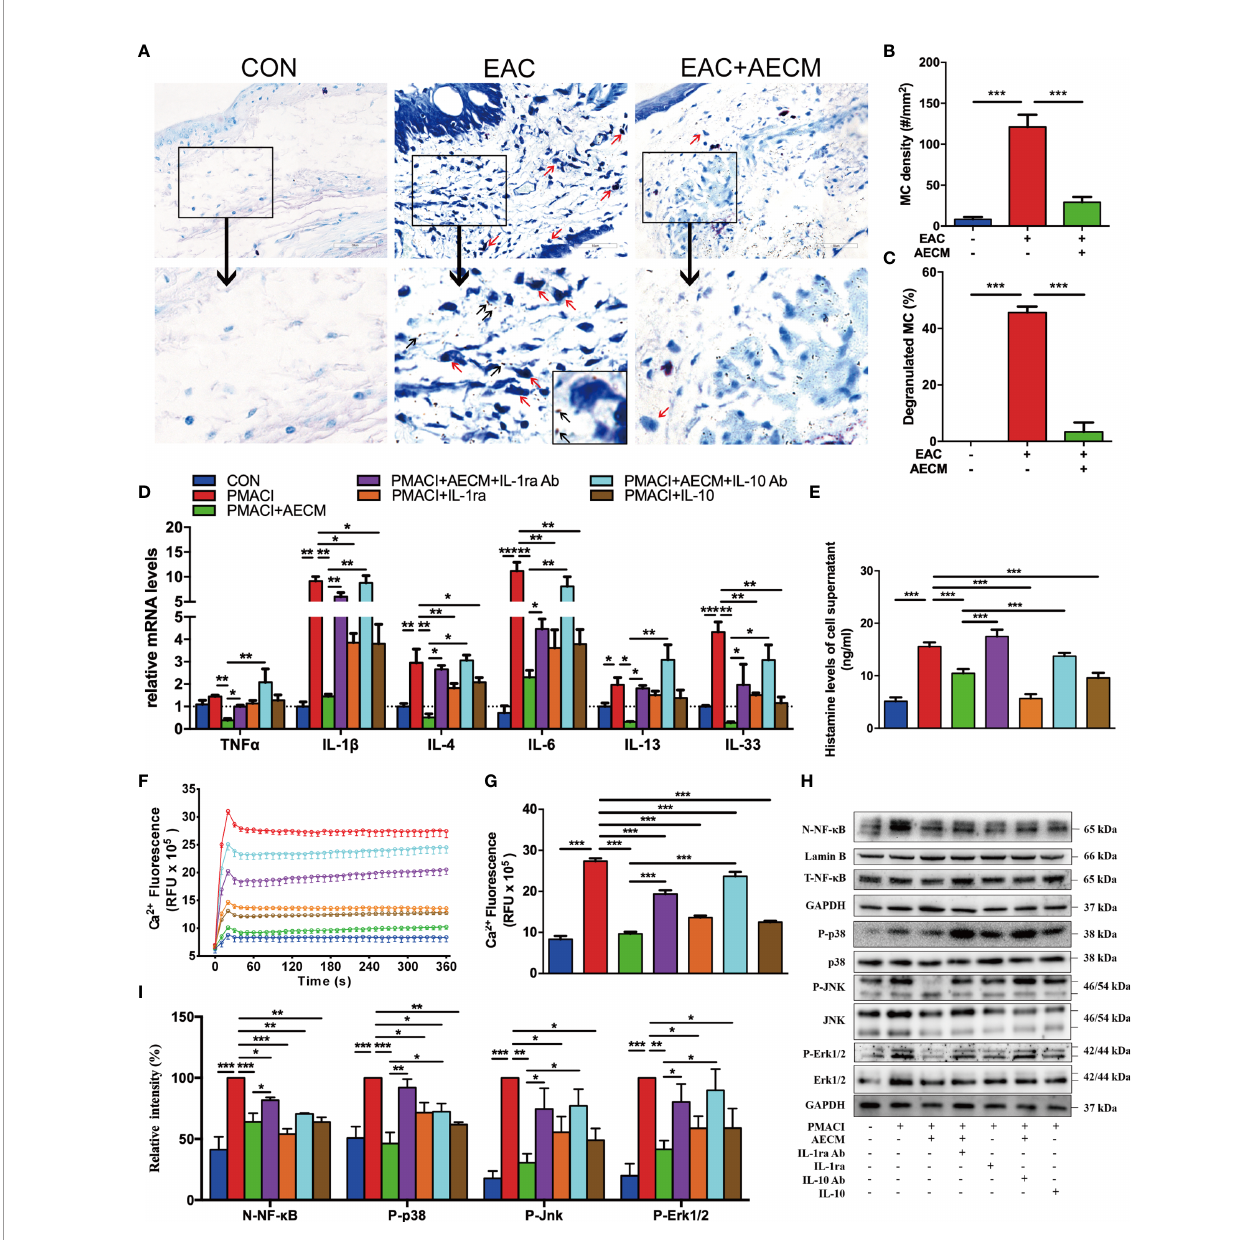
FIGURE 5 | AECM inhibited MC function. (A) Representative images of toluidine blue staining of MC in the conjunctiva of mice in different groups. The red arrows represent the dark blue staining of the degranulated MC, surrounded by many small dark particles (black arrow). Scale bar, 50 m m. (B, C) Quanti fi cation of the MC (B) and degranulated MC (C) in the conjunctiva of mice in each group. At least six representative sections of the conjunctiva were counted. At least three mice were used in each group. (D) The mRNA levels of cytokines in HMC-1 cells in each group as indicated. Data were collected from at least three separate experiments, and the data are expressed as the mean ± SEM. (E) Histamine concentration in the supernatant of HMC-1 cells in different groups as indicated by ELISA. (F) Ca 2+ i response in HMC-1 cells in different groups. (G) Quali fi cation of dynamic changes of Ca 2+ i in HMC-1 cells in different groups over 180 s. (H) Western blot analysis of the protein levels of nuclear and total NF- k B, p-P38 and P38, p-JNK and JNK, p-Erk1/2 and Erk1/2 in different treated HMC-1 cells. The level of Lamin B was used as an internal control of nuclear protein, and GAPDH was used as an internal control of the total protein of the cell lysate. N-NF- k B represents nuclear NF- k